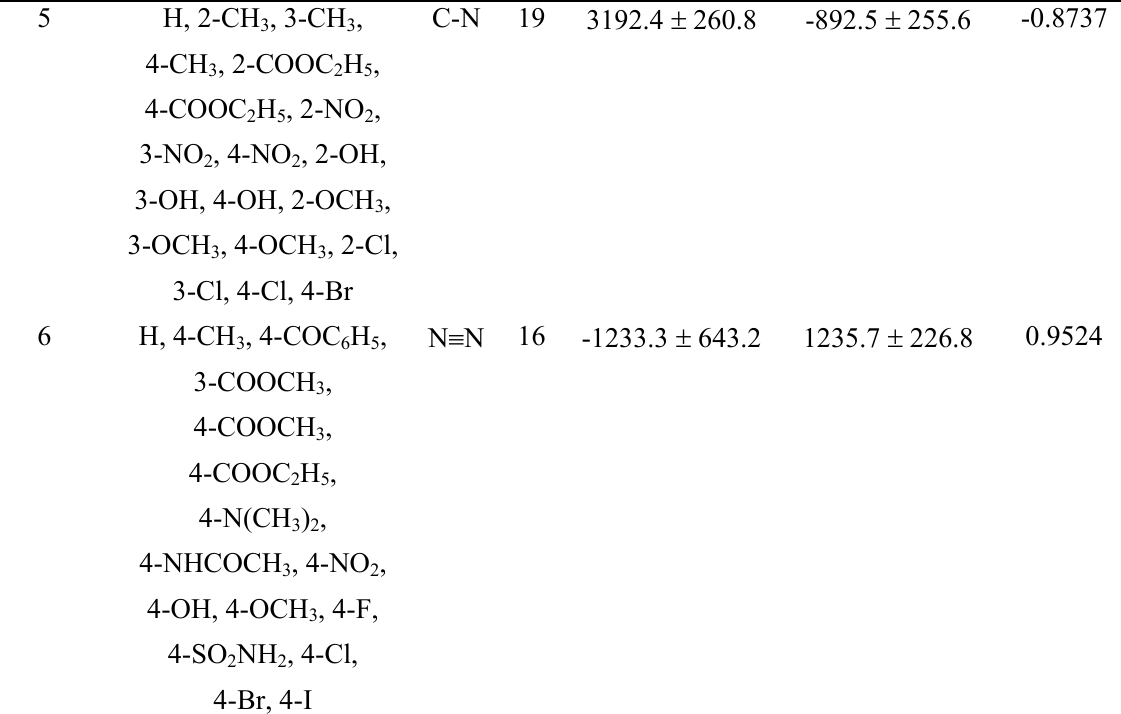
, 4-COOC H , 4-NH , 4-N(CH 3 2 5 2 NH , 3-Cl, 4-Cl, 4-Br, 4-I. Correlation coefficient 2 2